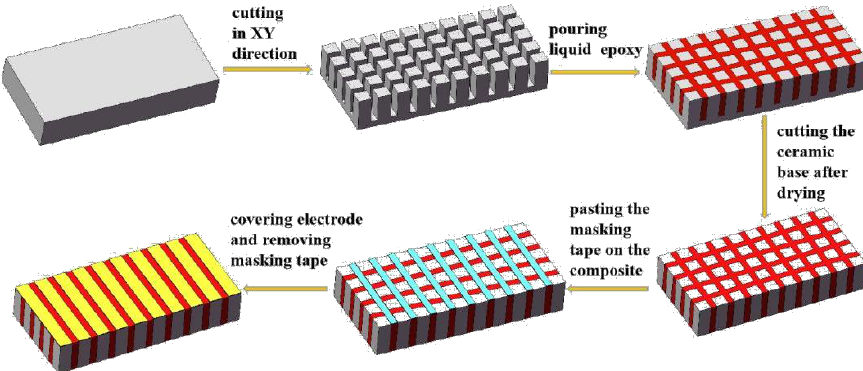
Figure 6. Fabrication method of the two-phase 1–3 piezoelectric composite